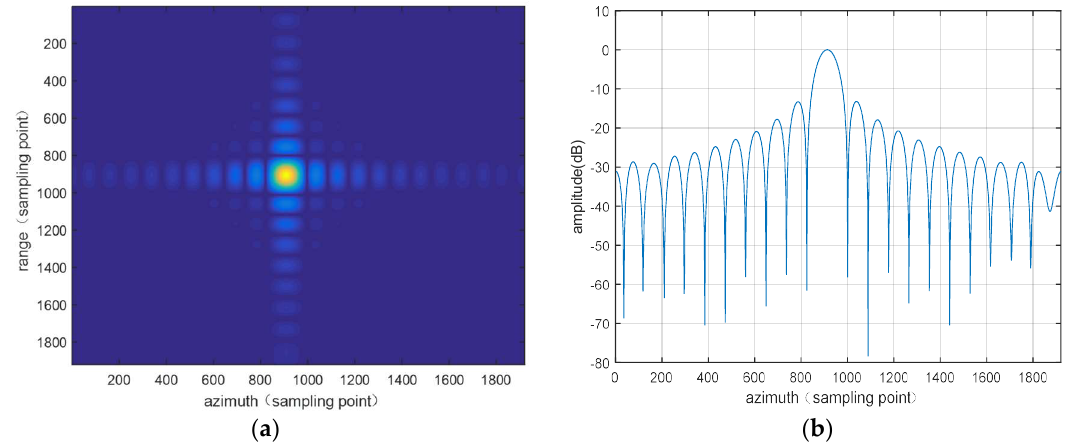
Figure 18. The simulation results for 6° bistatic angle with the consideration of the TCR optimum boresight. ( a ) The point target image after upsampling 48 times; ( b ) the azimuth profile based on the results of the electromagnetic simulation.